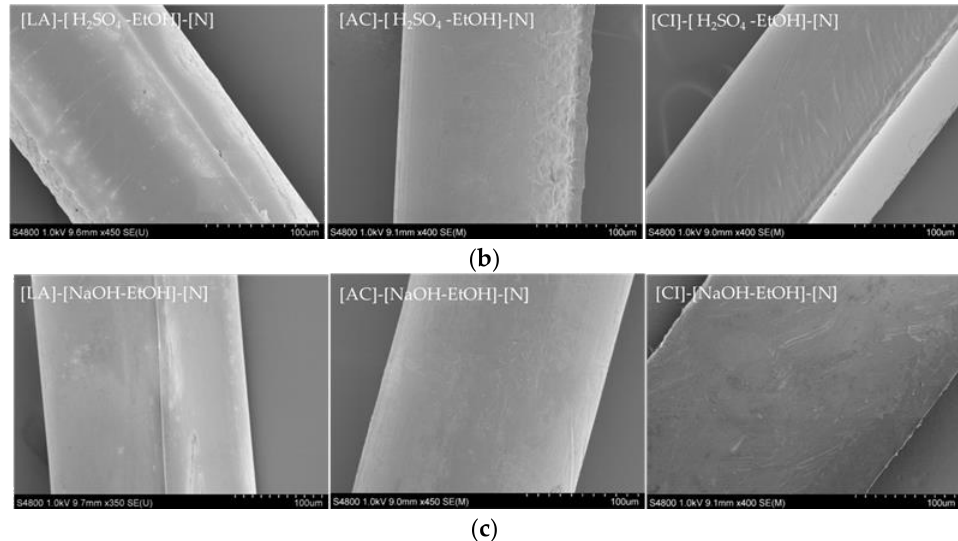
Figure 2. SEM images of chitosan monofilaments. Filaments prepared with ( a ) adipic acid as a solvent in different coagulation baths without and with dewatering; ( b ) lactic acid, acetic acid, or citric acid as solvents in H 2 SO 4 -EtOH bath without dewatering; and ( c ) lactic acid, acetic acid, or citric acid as solvents in NaOH-EtOH bath without dewatering. All images have been taken with the same magnification and a representative scale bar is shown in Figure 2a.